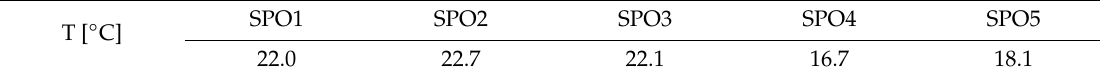
Figure 13. ( a ) Fragmentary external wall insulation from the inside (compare with Figure 1). The appearance of the so-called edge bridges. ( b ) Momentary distribution of temperature field on the wall surface insulated and non-insulated from the inside. The temperatures indicated on the thermogram are presented in Table 3. Table 3. Momentary surface temperatures from the thermogram in Figure 11.